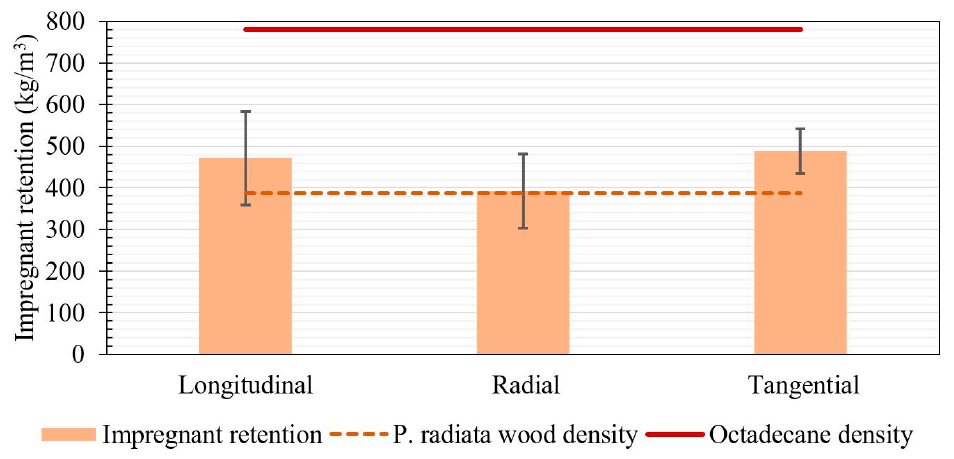
Figure 7. Retention of wood samples after impregnation with octadecane.